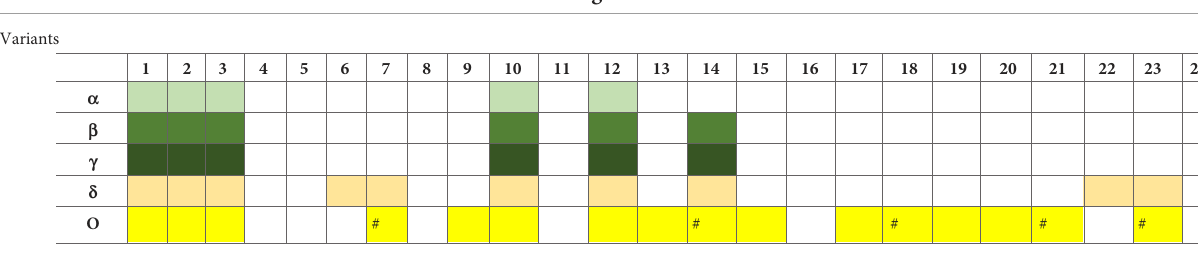
TABLE 2 Actual application of the criteria formulated by WHO and the CDC to the fi ve major SARS-CoV-2 variants. Labeling